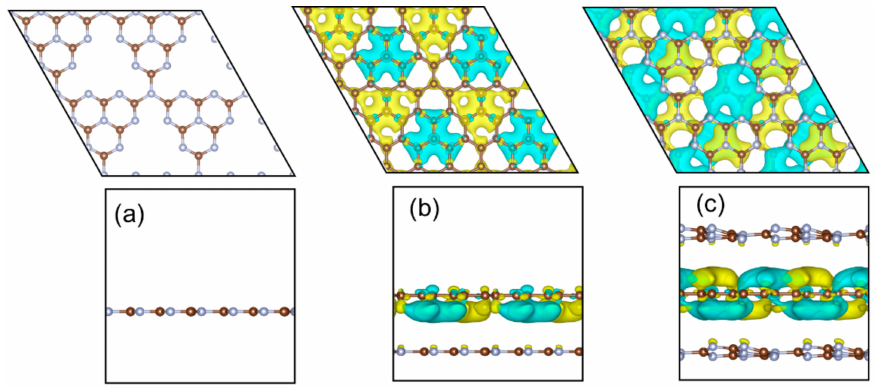
Figure 8. The optimization structures and di ff erent charge density of CN ( a ) and CCN ( b and c ), yellow (gain electron), cyan (lose electron).